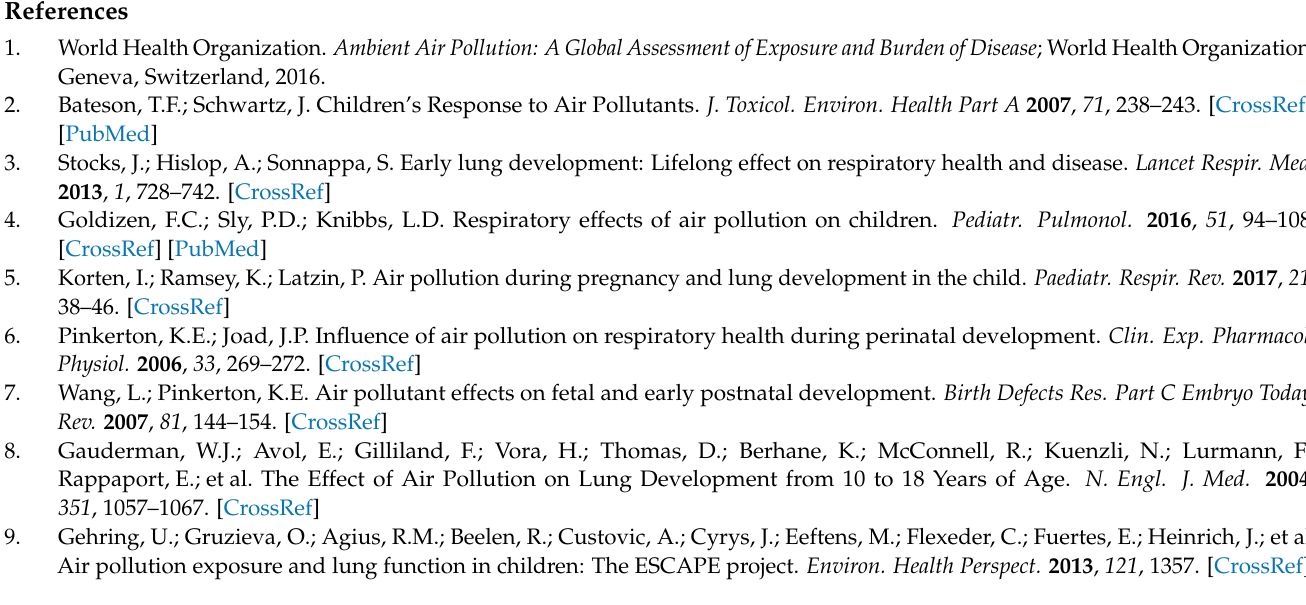
Figure A1. Selection of studies for review based on the Prisma strategy.